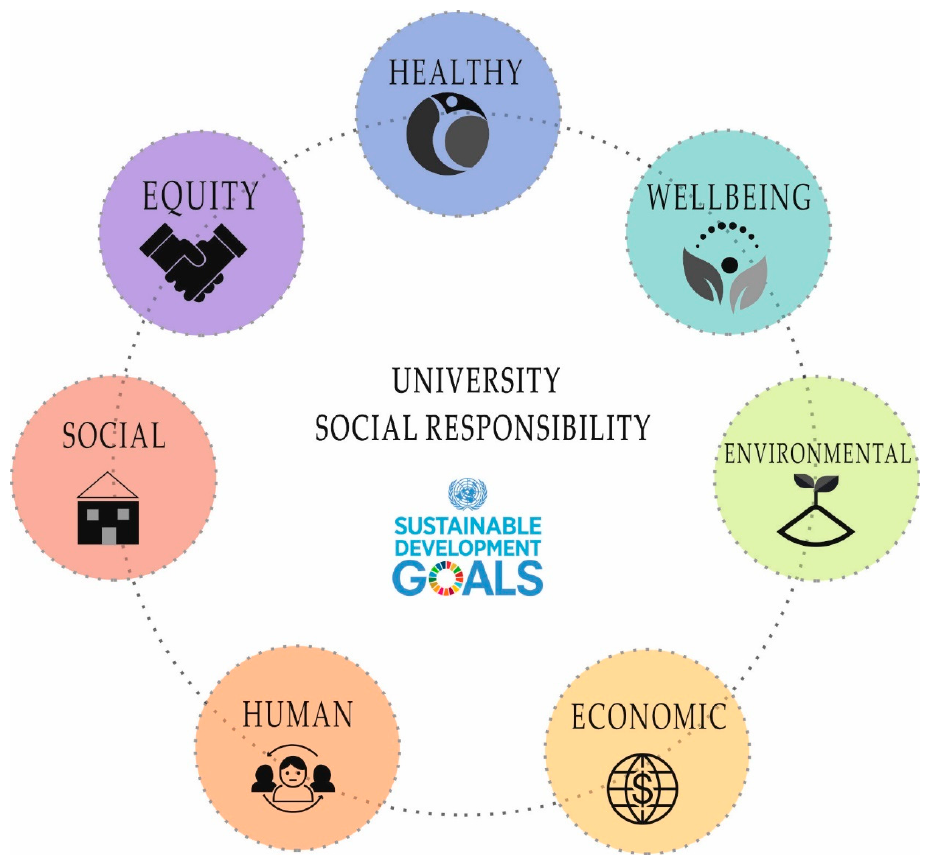
Figure 1. Conceptual structure of USR.